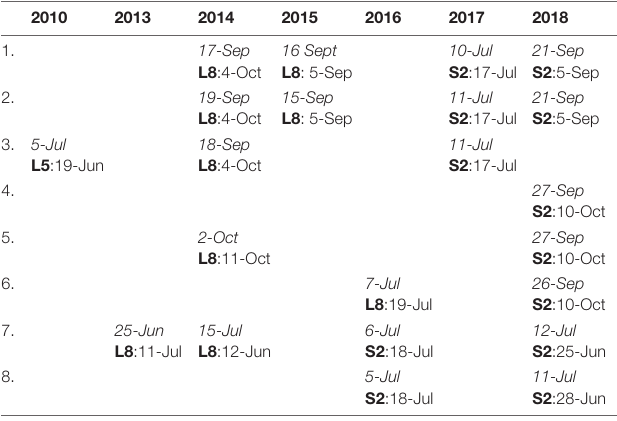
TABLE 1 | Dates of the field investigation and corresponding source of EO data sets: Landsat-5 TM (L5), Landsat-8 OLI (L8), or Sentinel-2 MSI (S2)